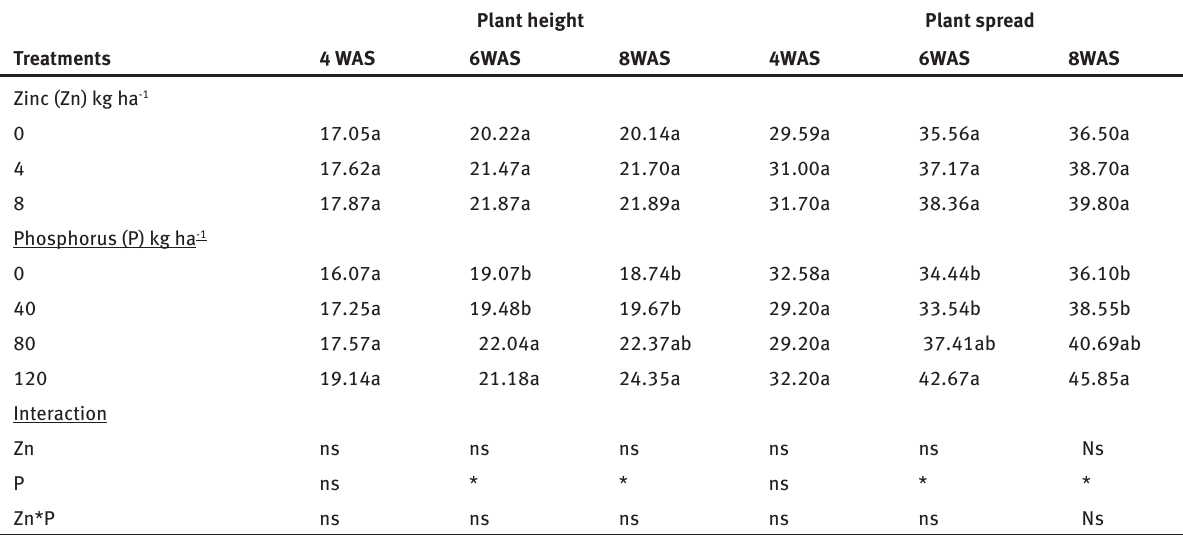
Table 2: Effect of Zn and P fertilizers on plant height and spread of groundnut based on the mean from 2017 and 2018 cropping seasons